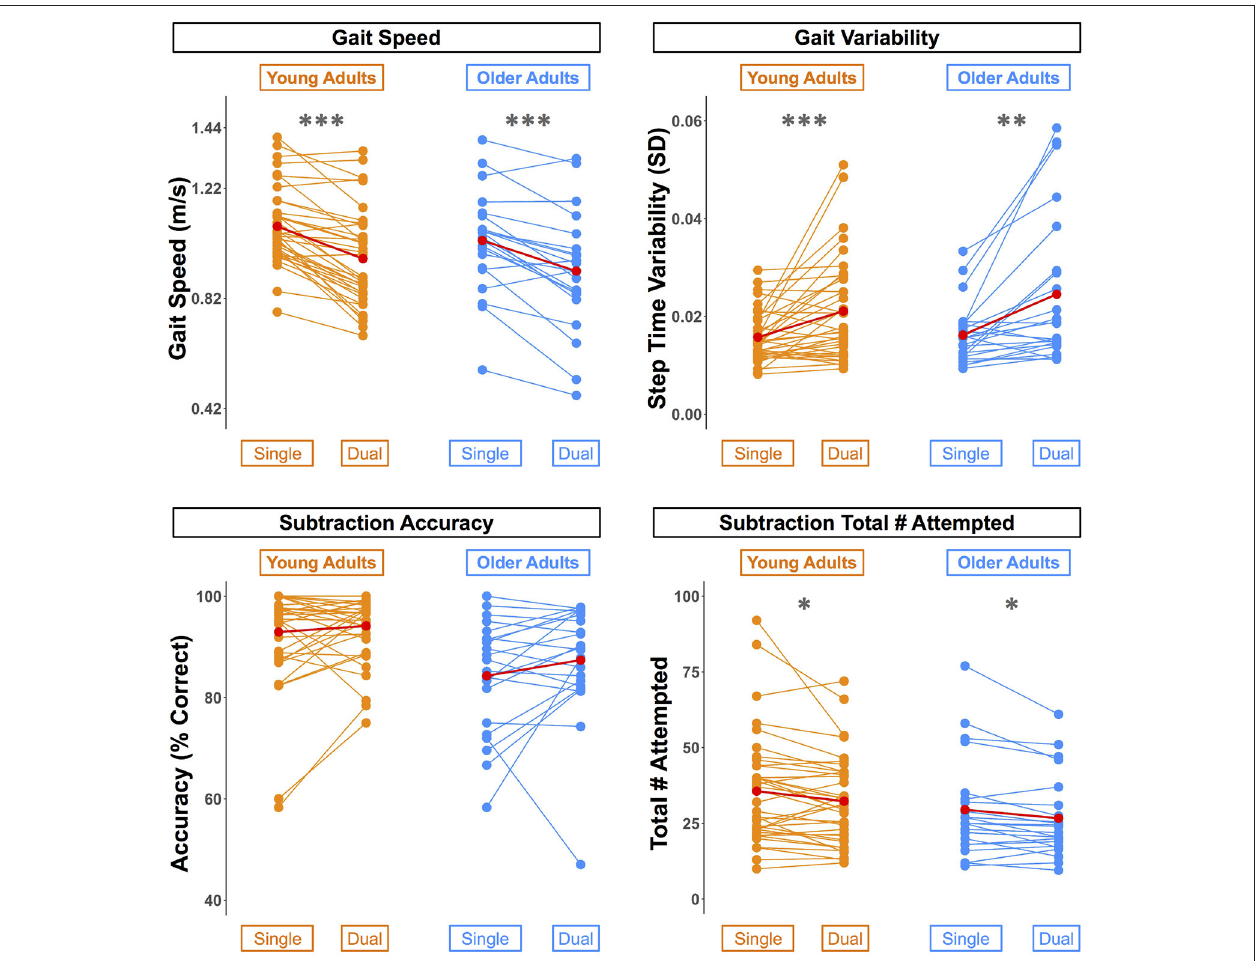
FIGURE 2 | Differences in walking and subtraction performance during single vs. dual task conditions. Gait and serial subtraction performance are depicted for each young (orange) and older (blue) adult. Each line represents one participant. Group means are shown in red. Across both age groups, gait speed slowed, gait variability increased, and number of subtraction problems attempted decreased from single to dual task conditions. * p FDR − corr < 0.05, ** p FDR − corr < 0.01, *** p FDR − corr < 0.001.